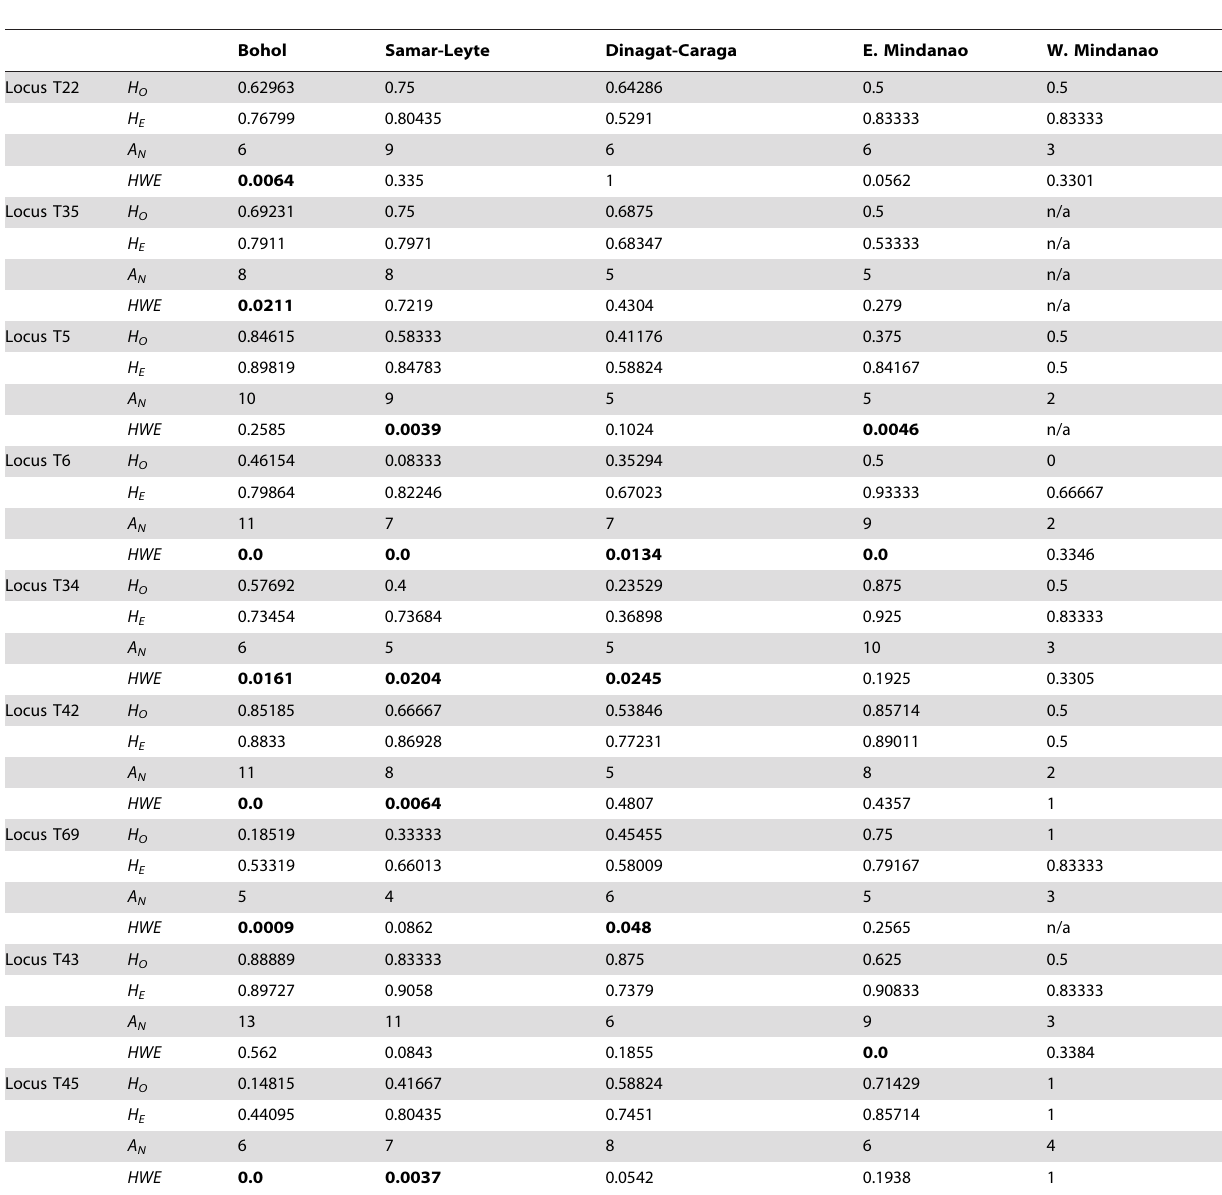
Table 3. Locus-specific microsatellite variation in 66 individuals of Tarsius syrichta from 17 localities (Fig. 2).